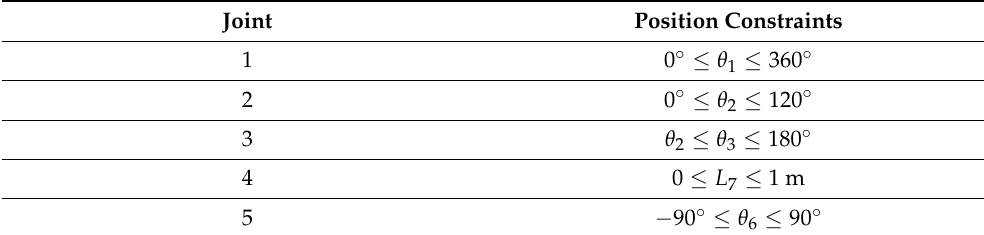
Figure 2. CAD models of the 5-DOF robot manipulator, ( a ) detailed and ( b ) simplified.